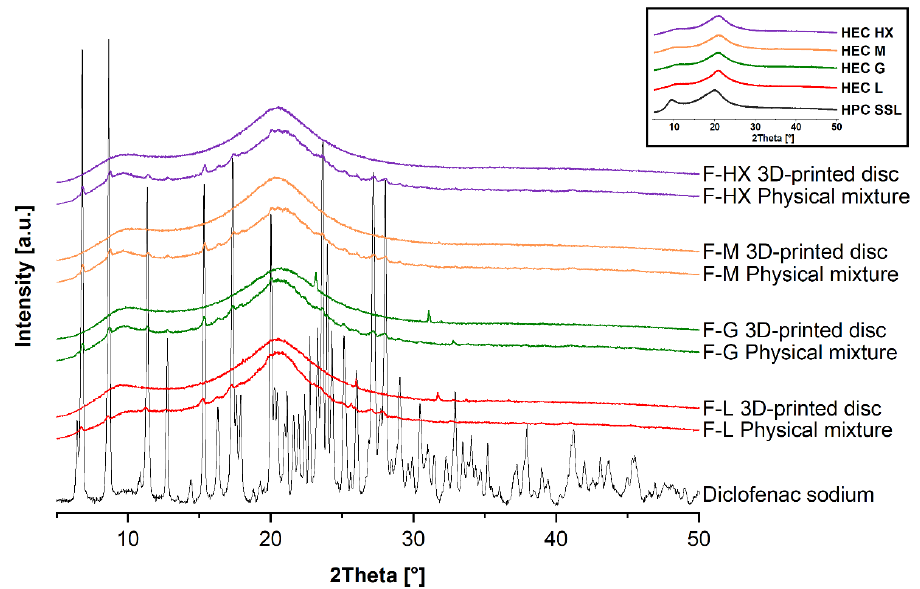
Figure 3. X-ray diffractograms of the raw materials (see inset), physical powder mixtures and 3D-printed formulations (F-L, F-G, F-M, F-HX).